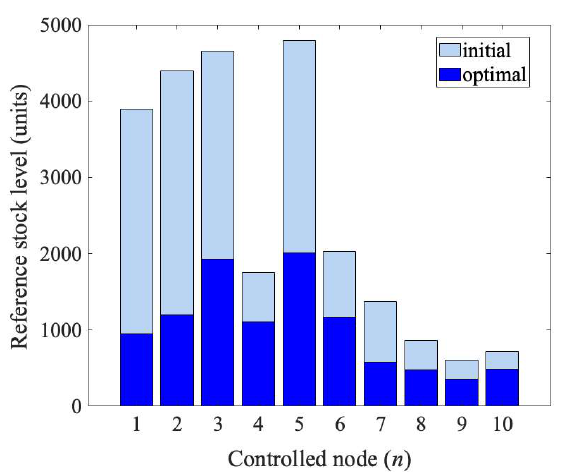
Figure 10. Initial and optimal reference stock levels (RSLs) for network N2.